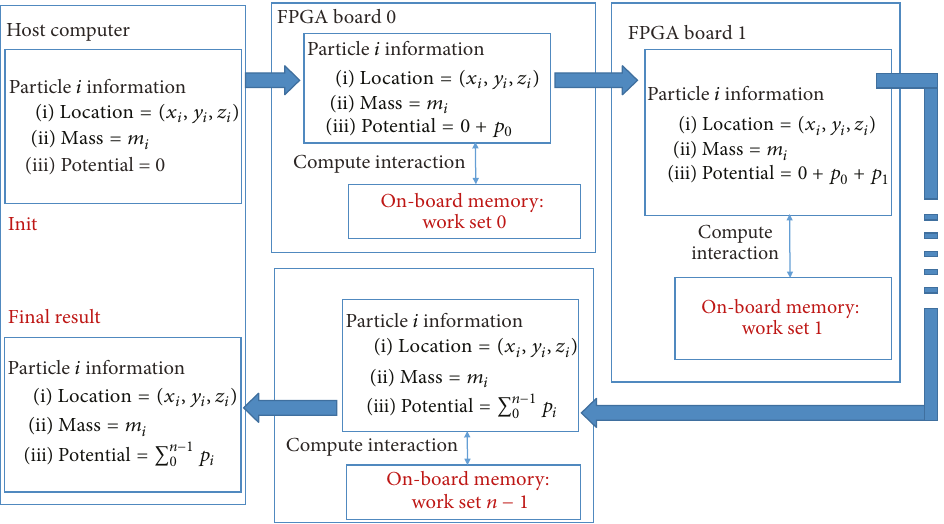
Figure 5: The data flow of